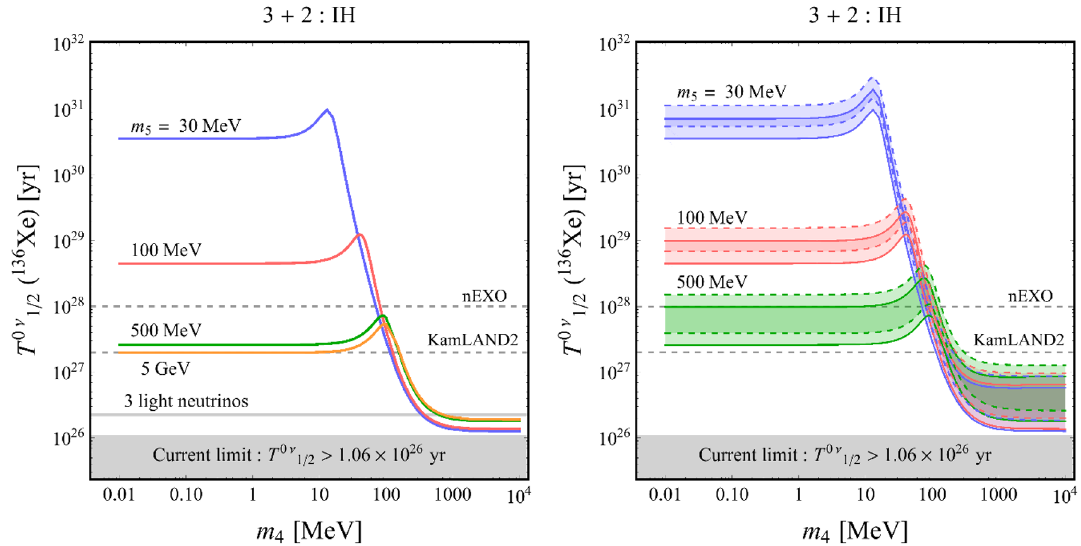
Figure 9 . Left panel: 0 (cid:23)(cid:12)(cid:12) half-life of 136 Xe as a function of m 4 for m 5 = 30 MeV (blue), m 5 = 100 MeV (red), m 5 = 500 MeV (green), and m 5 = 5000 MeV (orange) in the IH. The gray hori- zontal line is the predicted half life for the standard mechanism for the same choices of neutrino pa- rameters and LECs. Right panel: same as left panel but now we included uncertainties from NMEs and LECs. Bands correspond to m 5 = 30 MeV (blue), m 5 = 100 MeV (red), m 5 = 500 MeV (green). p since U (cid:24) m =m . The scaling with m 4 breaks down for larger values of m e 5 5 l 5